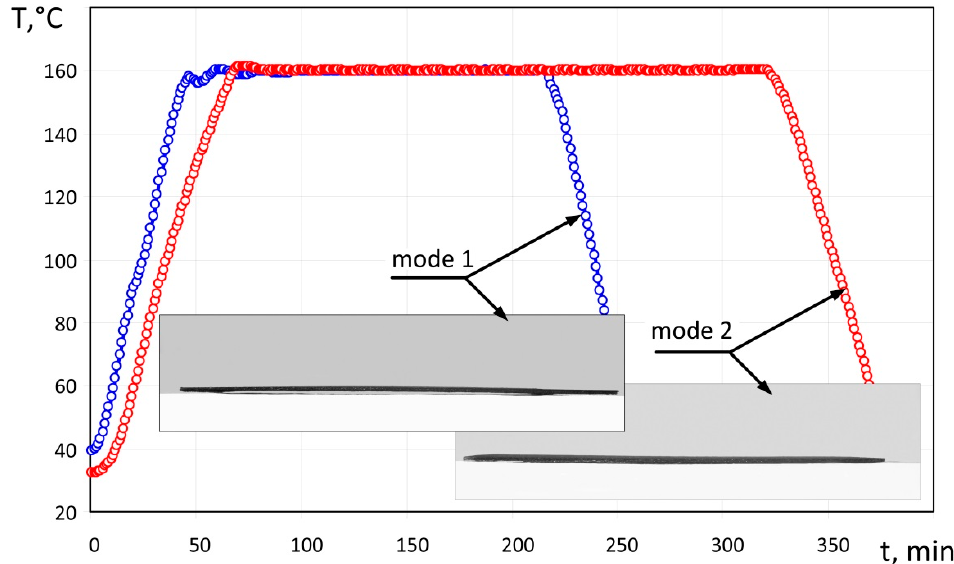
Figure 6. Moulding modes No. 1 and No. 2, and specimens obtained with the use of these modes.